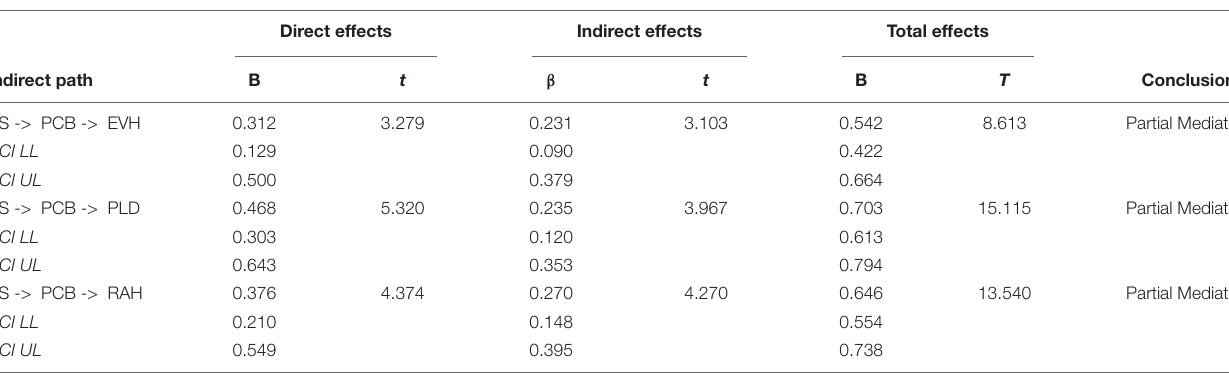
TABLE 5 | Direct, indirect, and total effects.